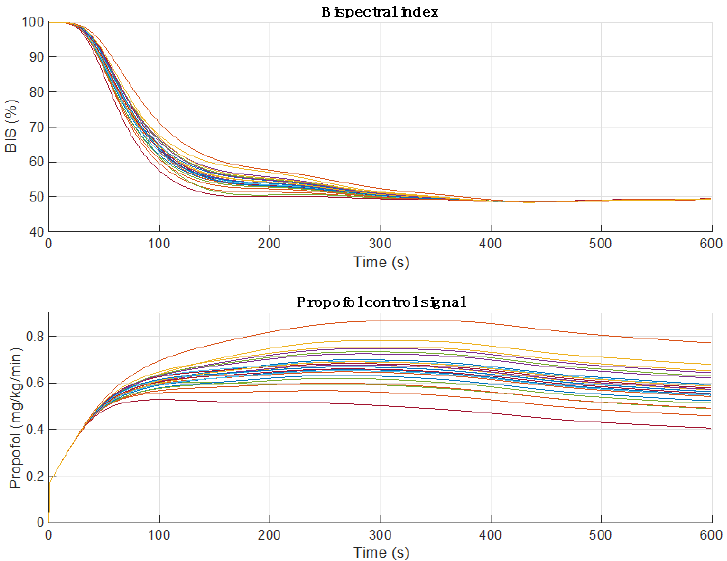
Figure 21. BIS response and Propofol control values for the 24 patients considering a 1 s dead time in all cases.